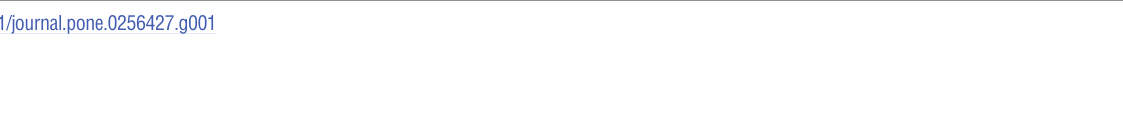
PLOS ONE | https://doi.org/10.1371/journal.pone.0256427 August 26, 2021 5 /